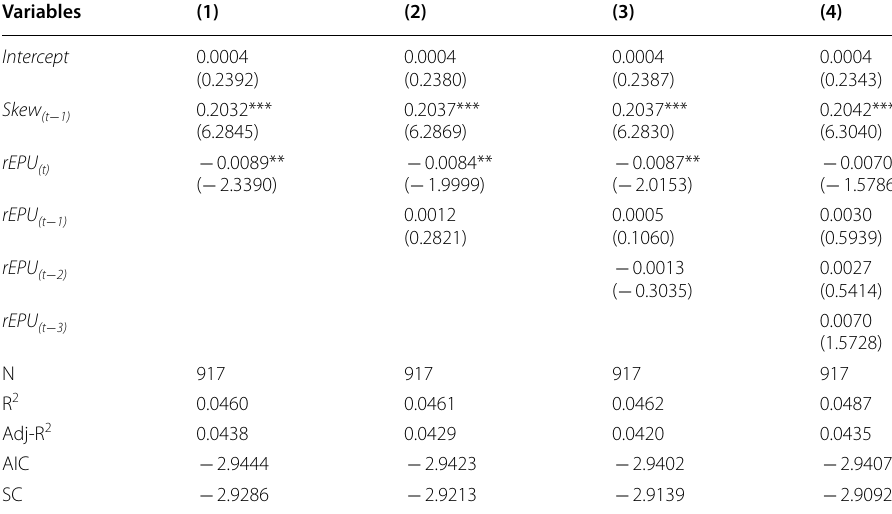
*** , **, * represent statistical significance at 1%, 5%, and 10% levels, respectively. The t‑statistics are presented in the brackets